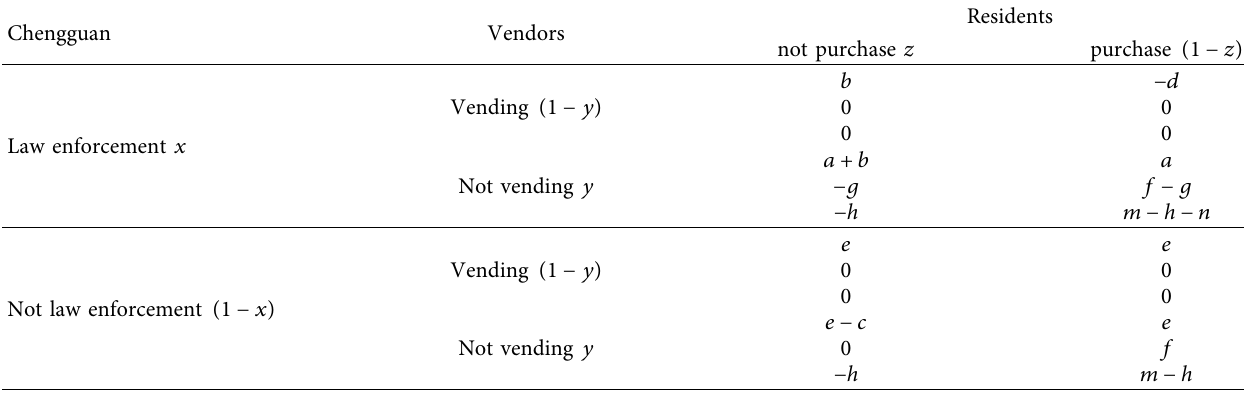
Table 1: Payoff matrix of the tripartite